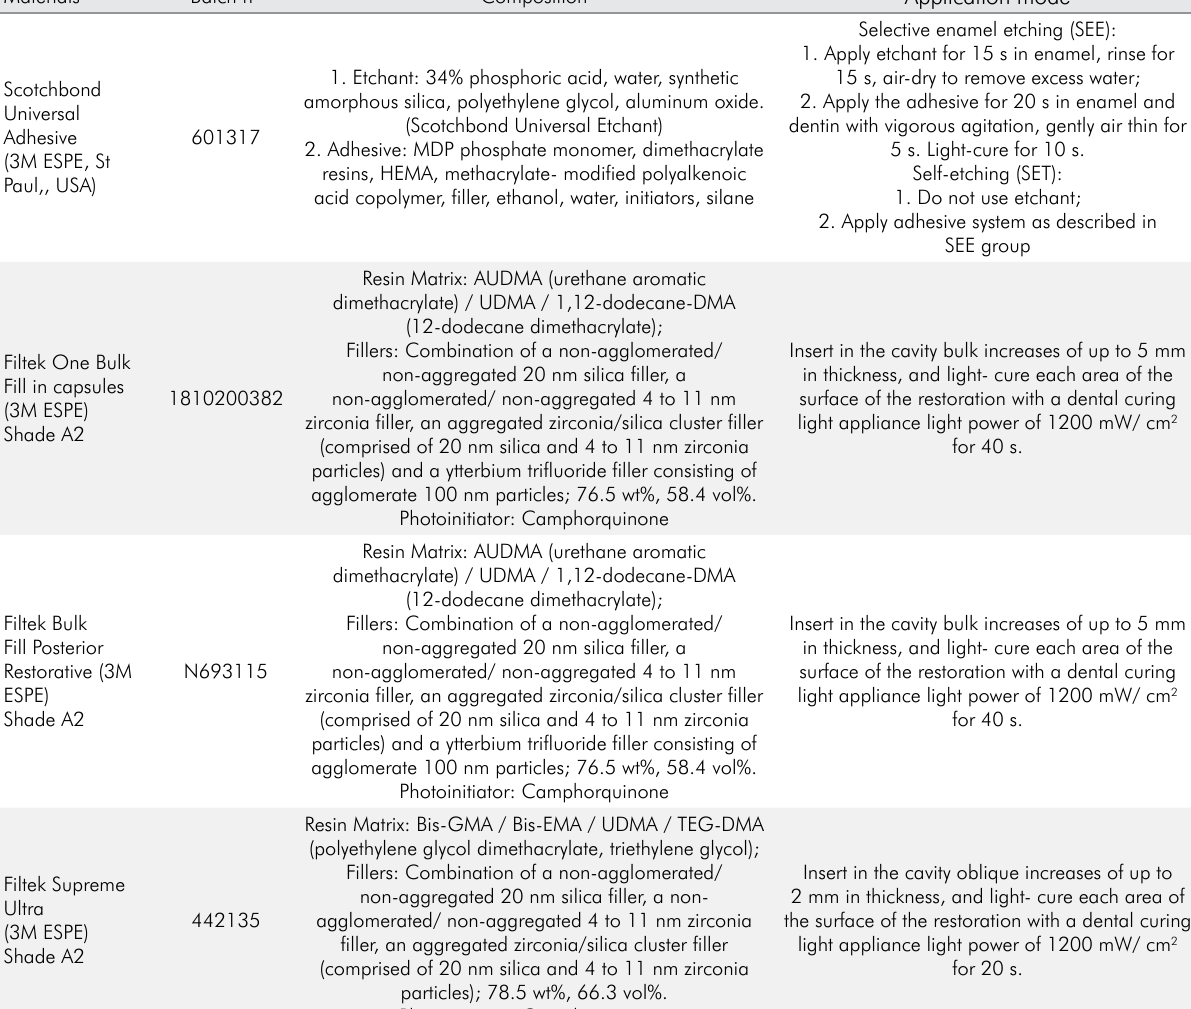
Table 1. Composition and application mode of materials used in the